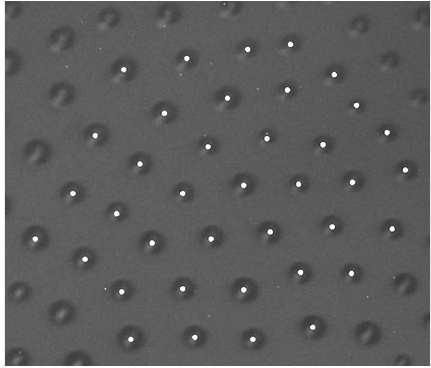
Figure 2. Droplets with hexagonal ordering in a film region of uniform thickness. The structure is conserved in time. White dots show the droplet centers. The horizontal size of the image is 230 μm.